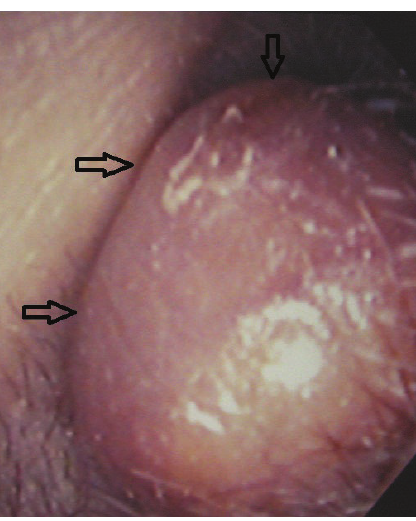
Figure 1: A smooth mass in the left external auditory canal (arrows).